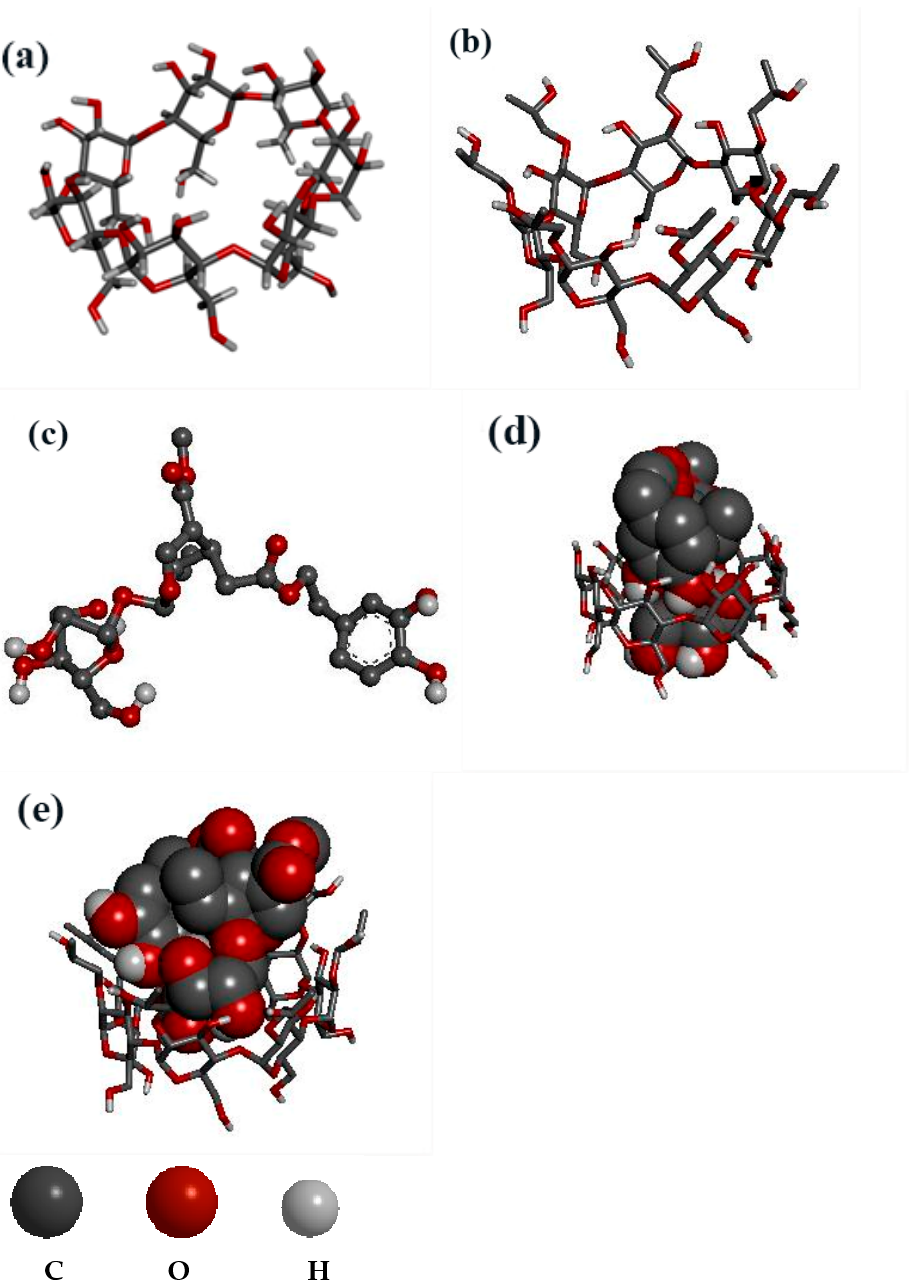
Figure 4. Molecular docking studies with ball-and-stick and sphere (CPK) representations: ( a ) beta-CD, ( b ) HP-beta-CD, ( c ) OL, ( d ) beta-CD:OL, ( e ) HP-beta-CD:OL. The abbreviations are the same as in Figure 1.